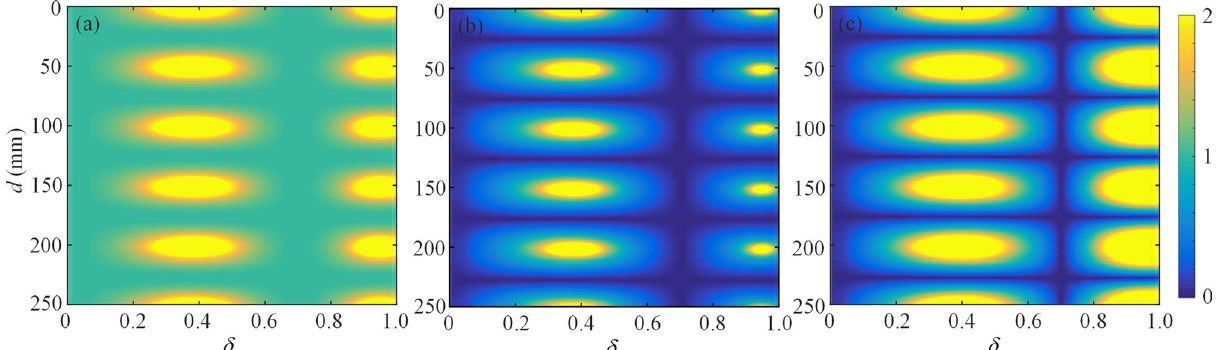
Figure 2. Scattering properties of the globally PT -symmetric system. The amplitude of the ( a ) transmission t , ( b ) left reflection r L , and ( c ) right reflection r R coefficients of the globally PT -symmetric system as functions of the values of d and δ for the normally incident wave at the operating frequency of 3,400